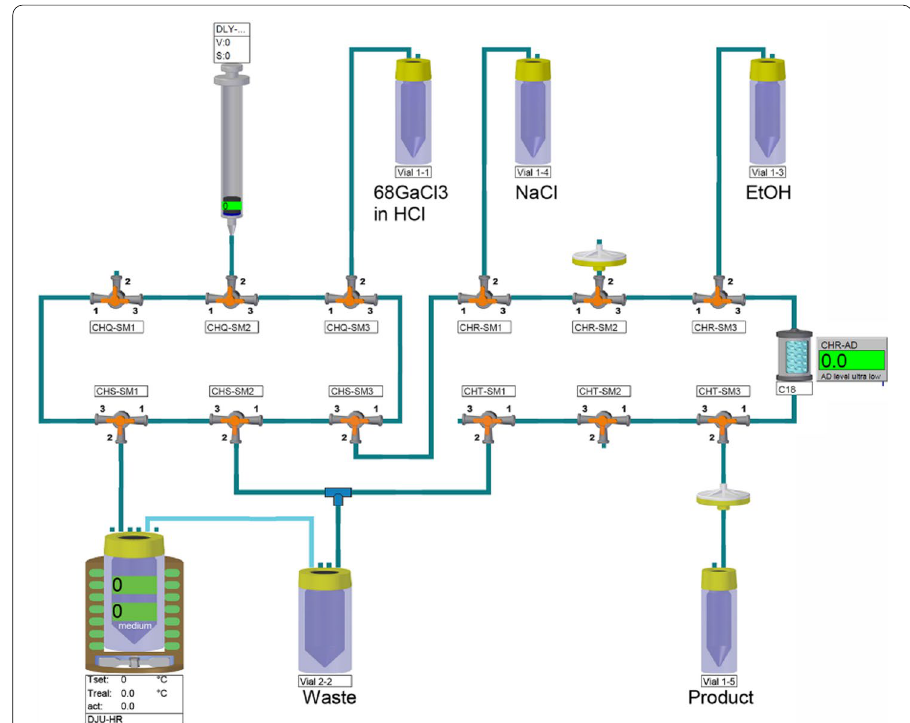
Fig. 2 Overview of the automated synthesis cassette for radiolabelling of PSMA‑11. This figure was obtained from Thisgaard et al. (2021) which was licensed under a Creative Commons License http:// creat iveco mmons. org/ licen ces/ by/4.